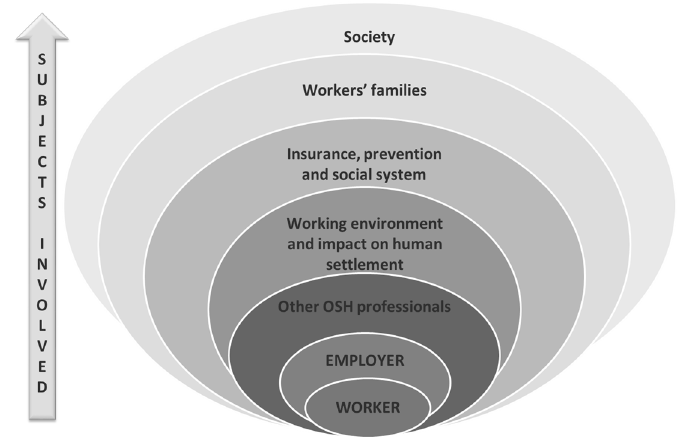
Figure 1. Subjects involved in decision-making by an occupational health physician . Source: modified from Brandt-Rauf, 1989 [39].